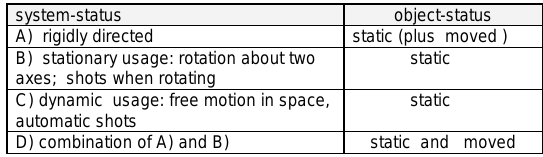
Table 2 Operating modes of the 2D/3D- camera